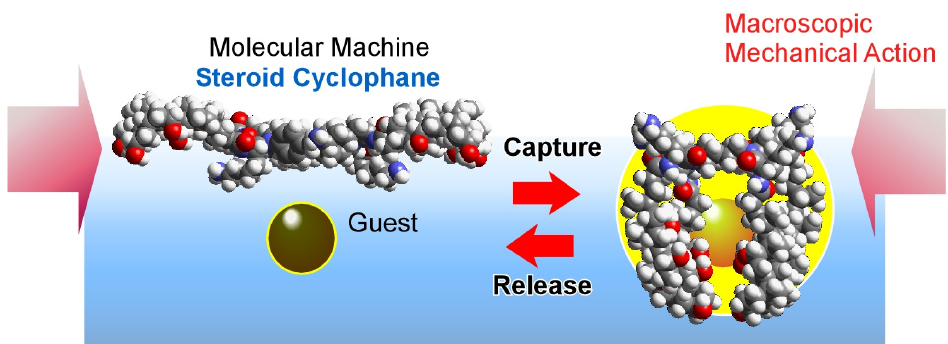
Figure 18. Manual actuation of a molecular machine using the steroid cyclophane at the air-water interface for reversible capture and release of a guest molecule.